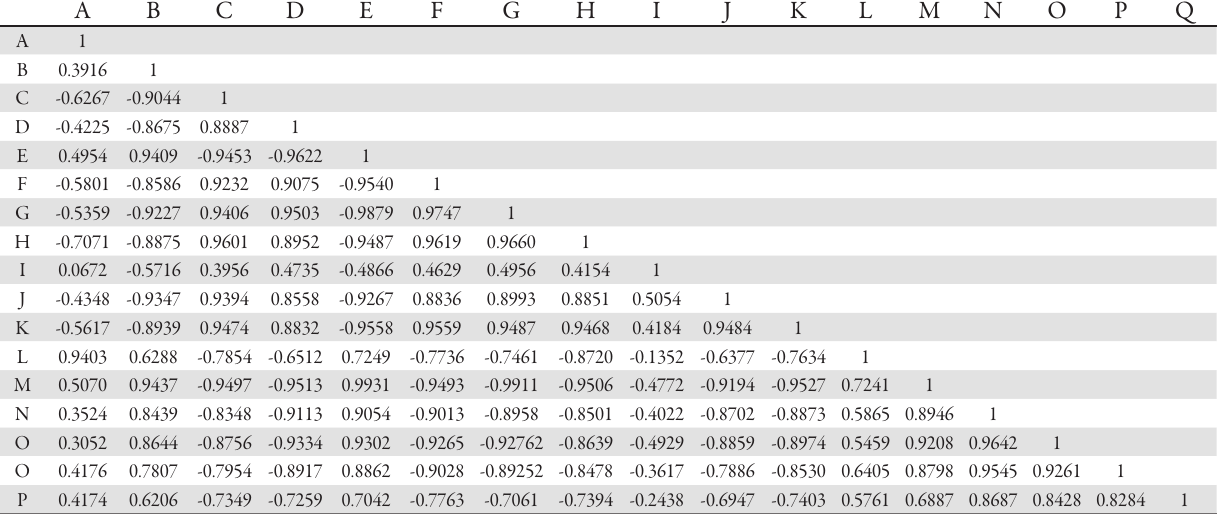
Tab. 2. Correlation coefficient (r) among the physico-chemical properties and phytoplanktons of Riwada reservoir from